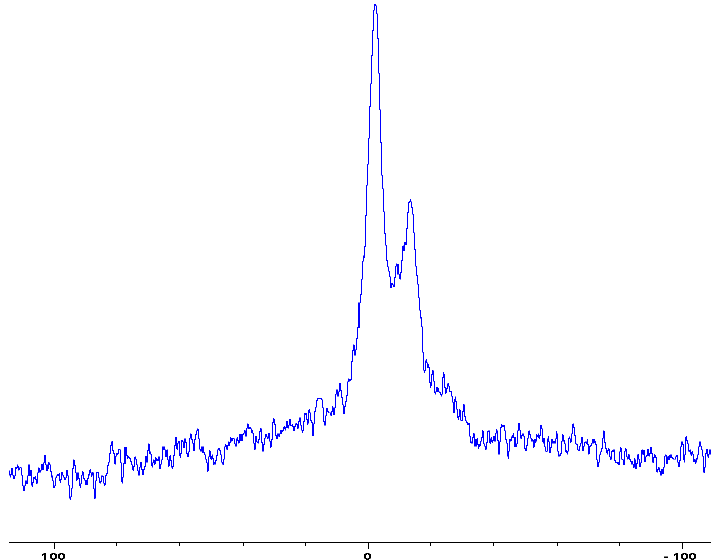
Figure 4. Solid-state 31 P-NMR spectrum of char obtained from fish gelatin + (NH 4 ) 2 HPO 4 (the abscissa denotes the chemical shift values, δ , in ppm and the ordinate corresponds to the signal intensity in arbitrary units).